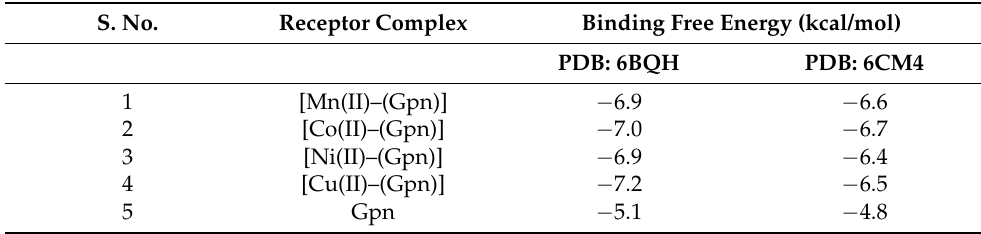
Table 2. The docking score of the four metal complexes docked with two receptors [serotonin (6BQH) and dopamine (6CM4)].